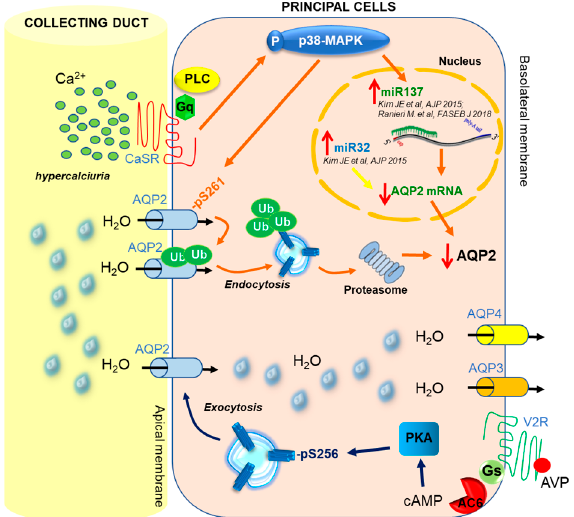
Figure 3. Schematic model. The proposed model shows that high urinary calcium levels in the collecting duct activate CaSR, resulting in the phosphorylation and activation of p38-MAPK that, in turn, phosphorylates AQP2 at Ser261, causing AQP2 internalization, ubiquitination (Ub), and proteasomal degradation. In parallel, CaSR signaling promotes the synthesis of miRNA-137 (orange arrows) via the activation of p38-MAPK, which results in reduced AQP2 mRNA translation (described in Ranieri et al., 2018 [66]). As reported by Kim et al. 2015 [96], also miRNA-32 (yellow arrow) is able to reduce AQP2 mRNA levels and consequently AQP2 abundance, however, the precise signaling pathway through which these events occur are still unknown.